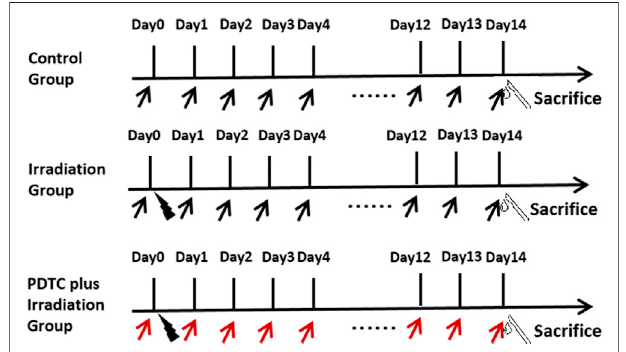
FIGURE 1 | Schedule of the experiment. Hearts of rats were irradiated with a single fraction of 20.0 Gy (black lightning bolt). PDTC (red arrow) or normal saline (black arrow) was intraperitoneally administrated at the dosage of 120 mg/kg 30 min prior to irradiation and continued to receive the daily injection until the 14th day